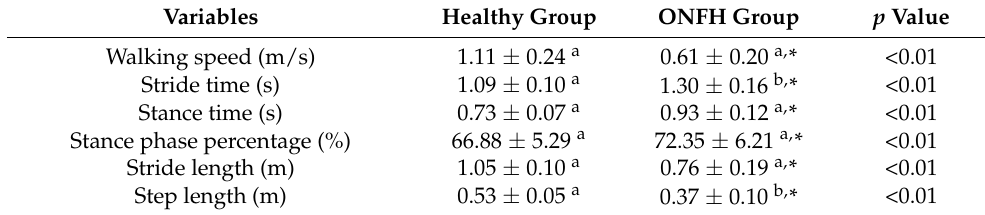
Table 2. Spatiotemporal variables in the ONFH group and healthy